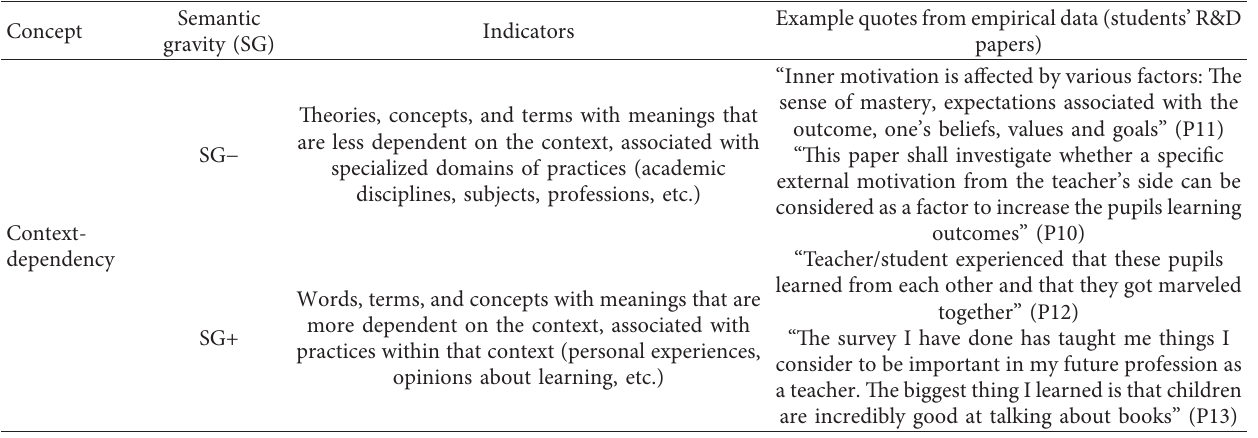
Table 1: An external language of description for sematic gravity (SG) in student papers.